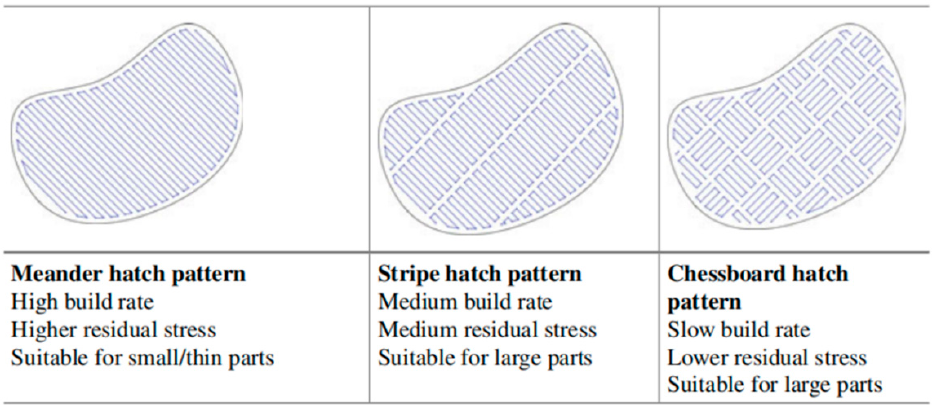
Figure 35. Characteristics of different scanning strategies [23].